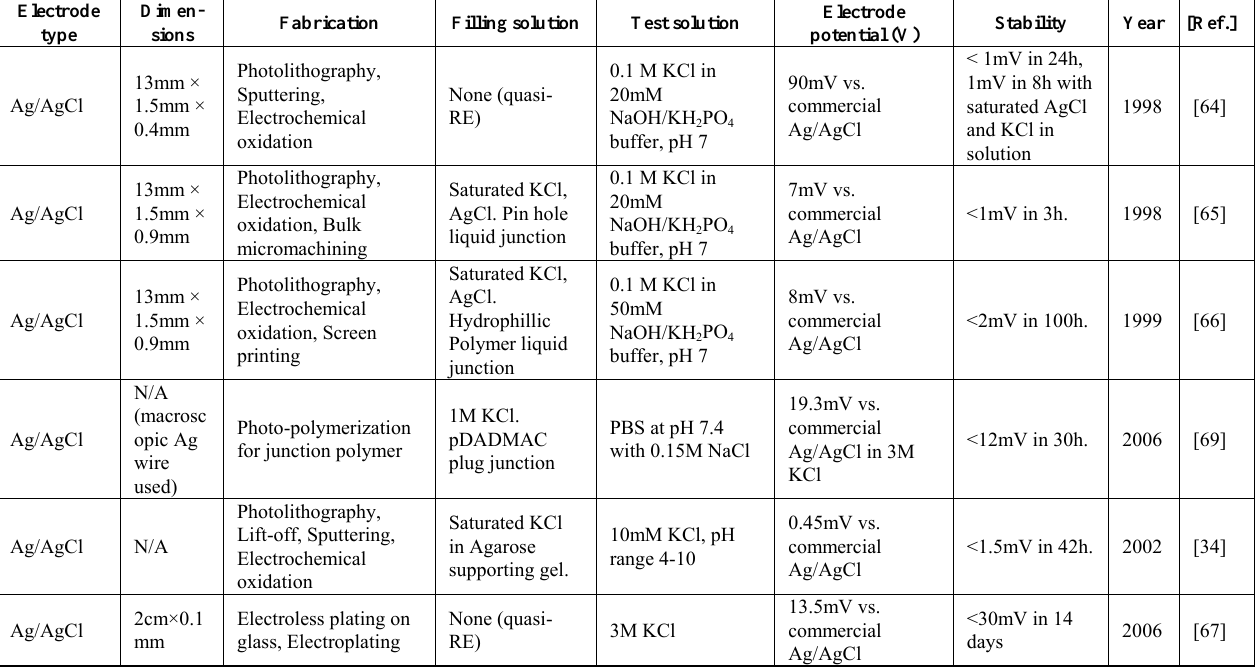
Table 1. Summary of the performance of microfabricated reference electrodes in the